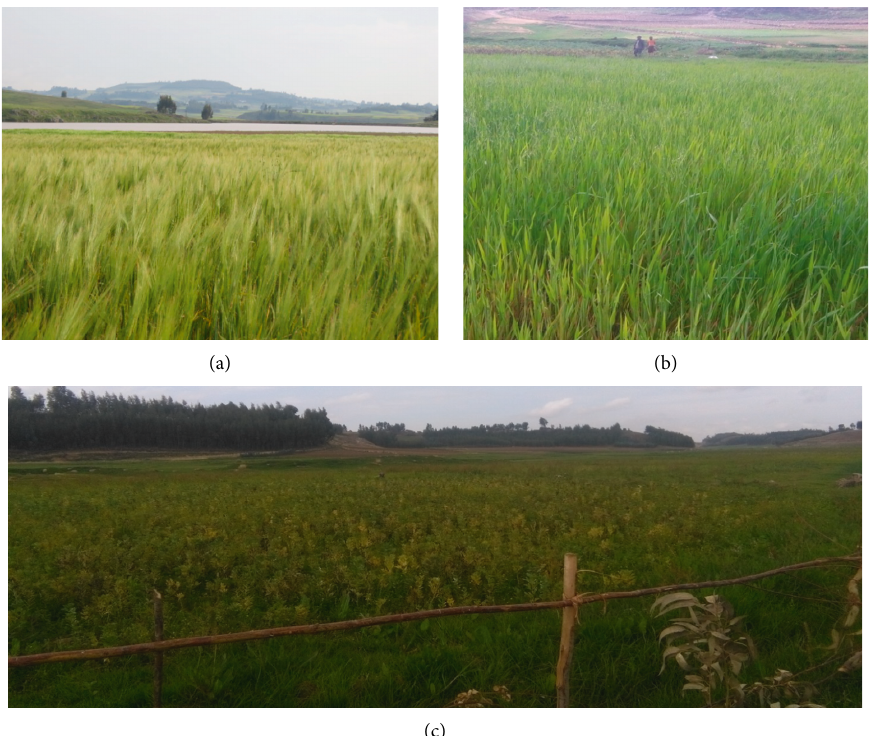
Figure 6: The crops, barley in Washa (a), and shalom and beans in Borale (b, c) under cultivation (Photos taken in May